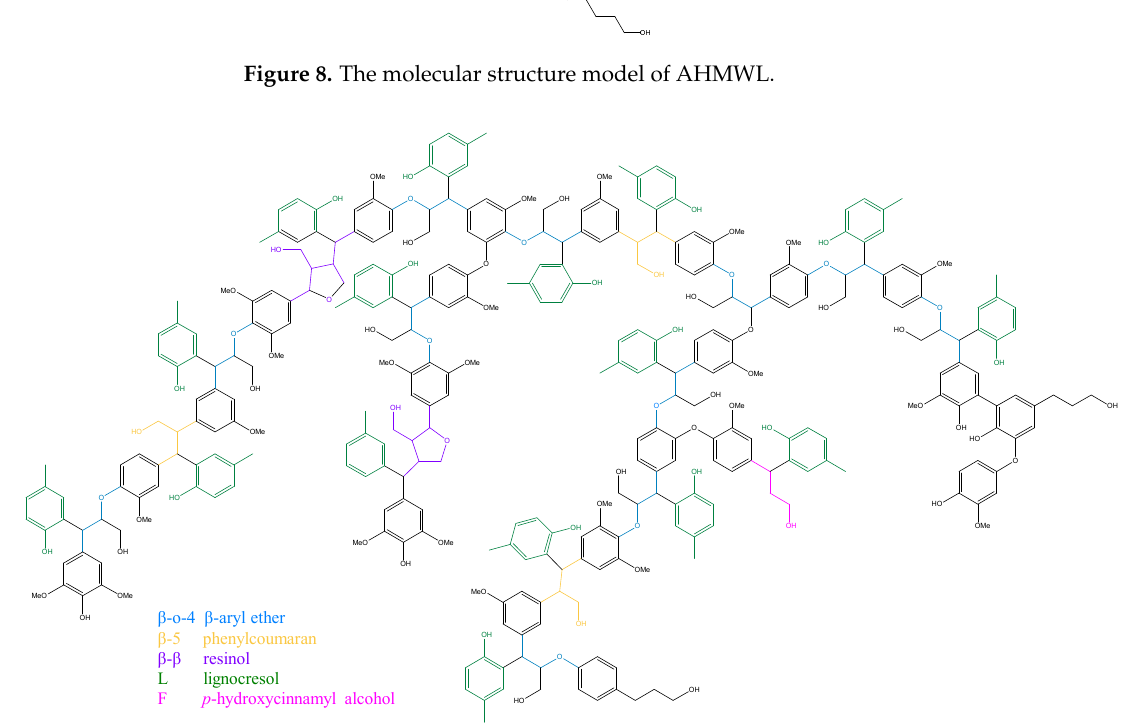
Figure 9. The molecular structure model of AHLC.